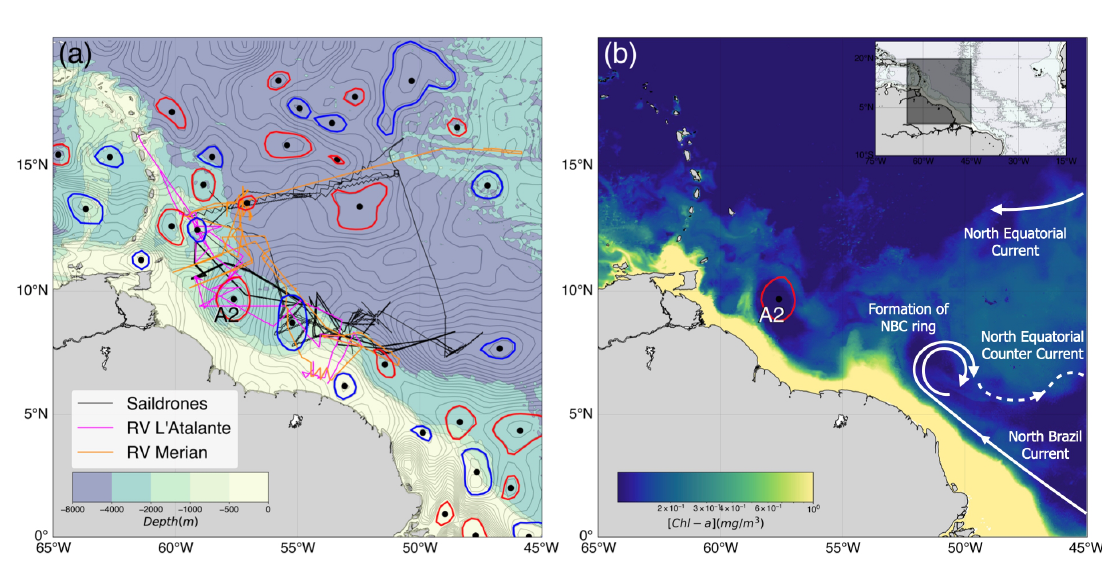
Figure 1. ( a ) Bathymetry of the tropical Atlantic Ocean (from the ETOPO2 dataset). The region of interest is delineated by the shaded gray square in the upper right panel. The absolute dynamic topography (ADT) contours for 30 January 2020 are shown in gray. The anticyclonic and cyclonic eddies detected by TOEddies are shown as red and blue contours, respectively. The NBC A2 ring discussed in this work is highlighted. The thin lines indicate the trajectories of 2 research ships and 5 Saildrones ™deployed during the EUREC 4 A-OA campaign. ( b ) Schematic of major ocean currents in the western tropical Atlantic superimposed on the 30 January 2020 chlorophyll-a field using the GlobColour gap-free chlorophyll-a product (GlobColour data, accessed on 18 January 2023 (http://globcolour.info) developed, validated, and distributed by ACRI-ST, France). The A2 detected by TOEddies on the same day is shown as red